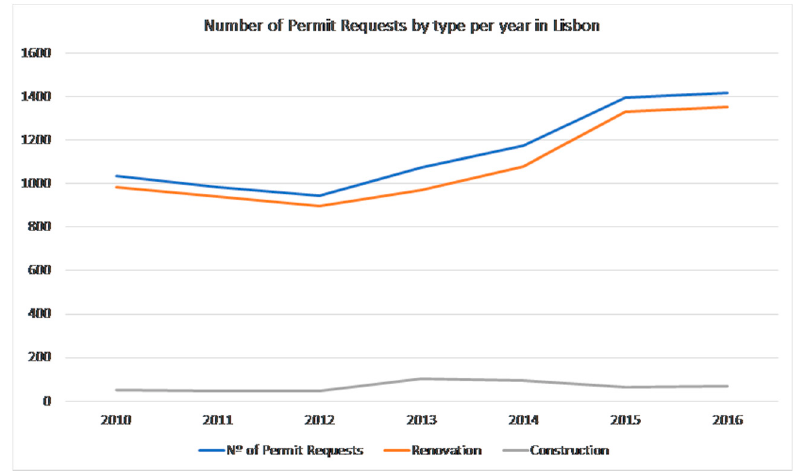
Figure 1. Number of permit requests per type per year in Lisbon. Source: Authors, based on Lisbon city building permit database.